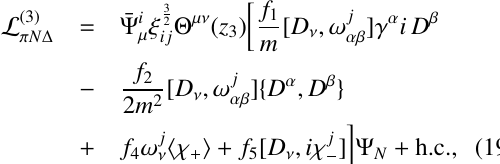
Figure 13. Correlation between the leading π Δ and π N Δ cou- plings. The central line corresponds to Γ Δ = 100 MeV while the band is obtained by varying Γ Δ in the range of 98 to 102 MeV. The dot-dashed lines show the correlation for other values of the width of the Delta. The box with the error bars are the results from the analysis of Ref. [84]. Figure inspired from